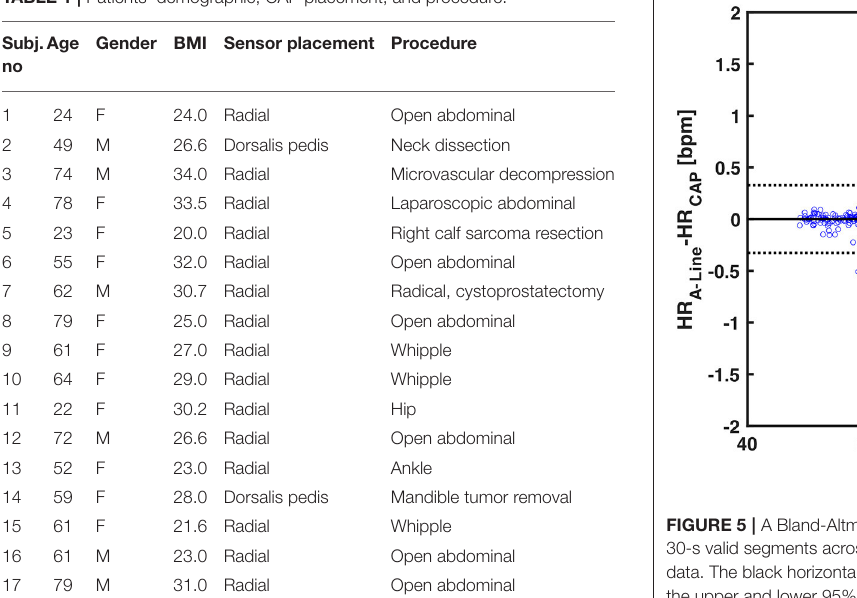
TABLE 1 | Patients’ demographic, CAP placement, and procedure.